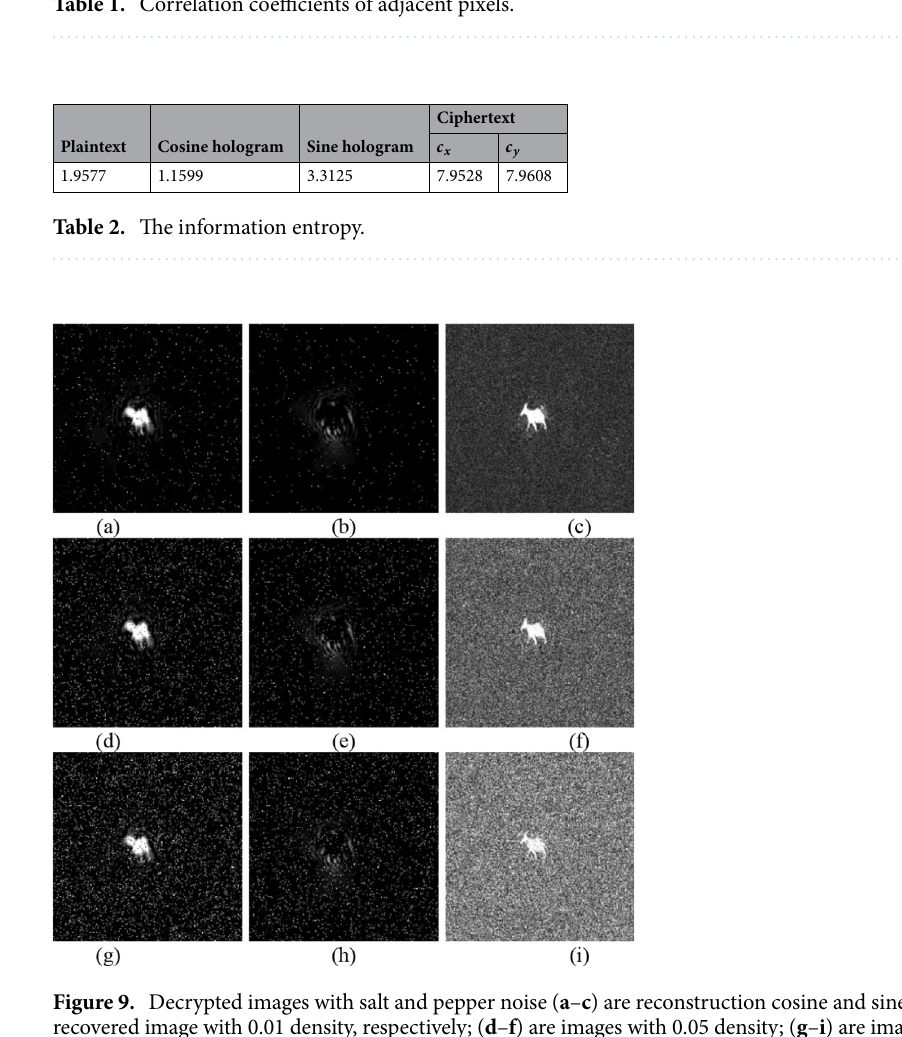
Table 1. Correlation coefficients of adjacent pixels.